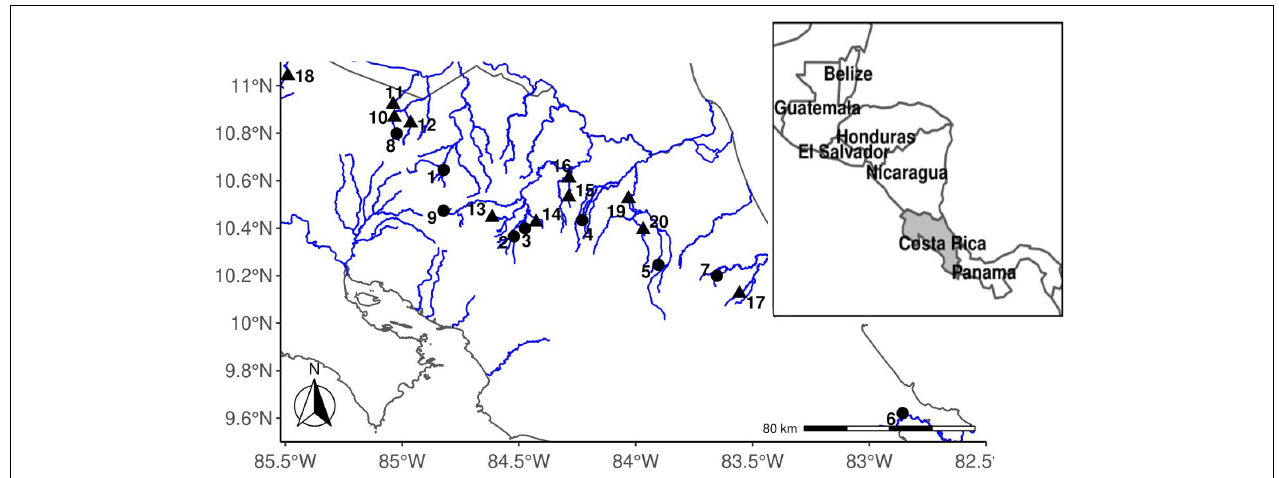
FIGURE 2 | Map of Costa Rica collection locations. Localities are numbered according to the site number found in Table 1 . High-predation sites are triangles; low-predation sites are circles.